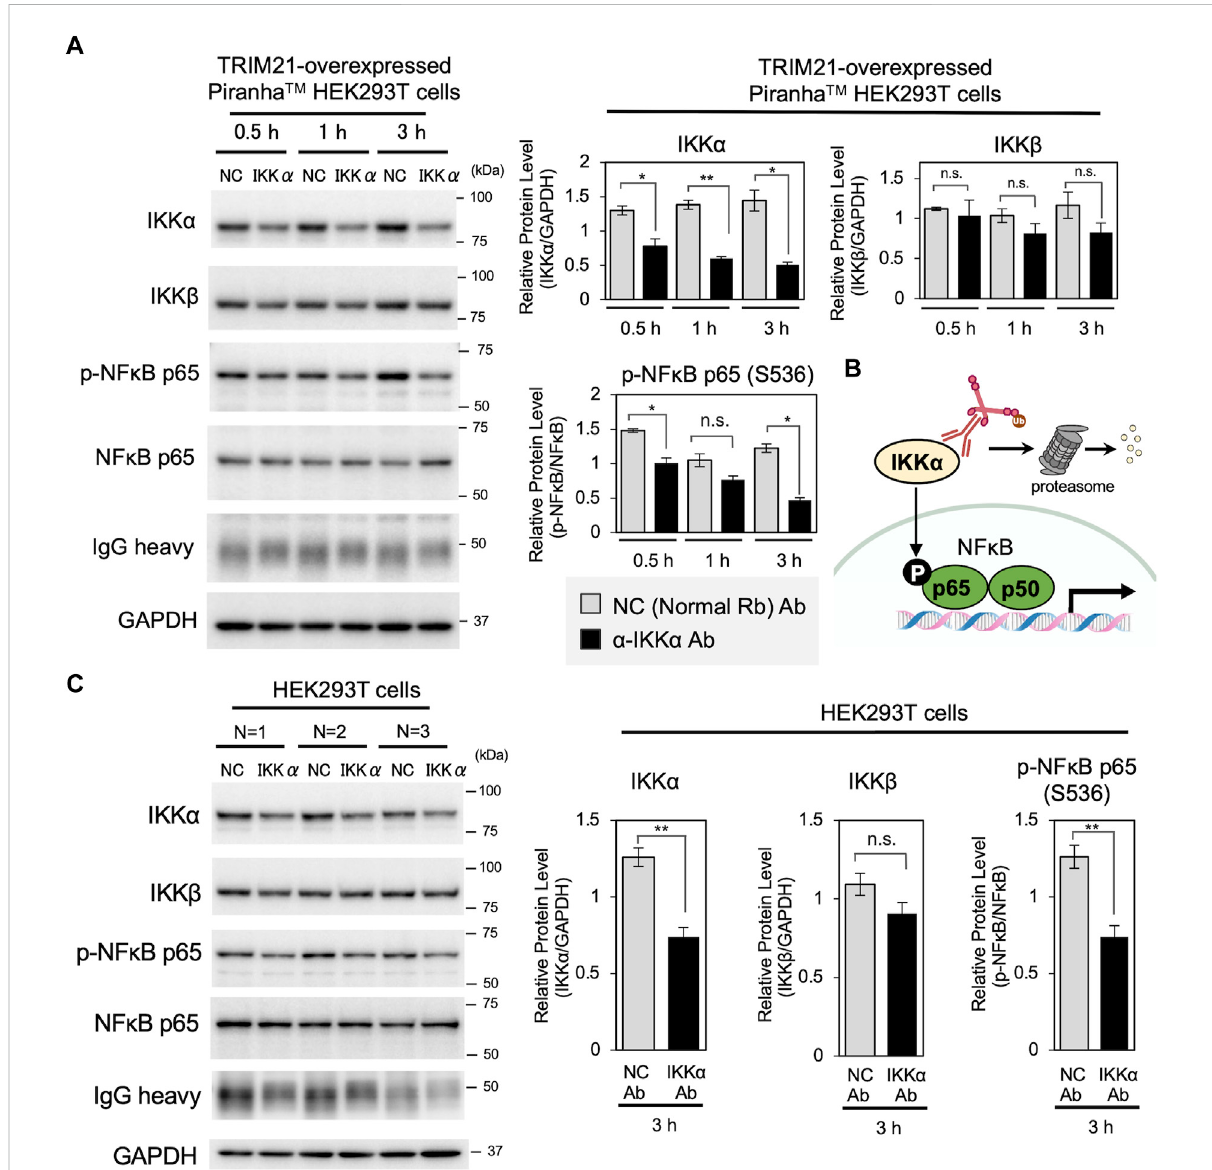
FIGURE 2 Acute degradation of IKK α by cell resealing technique-mediated Trim-Away. (A) Western blotting showing acute degradation of IKK α by cell resealing technique-mediated Trim-Away. TRIM21-overexpressed Piranha TM HEK293T cells were incubated for 0.5, 1.0, and 3.0 h after resealing with 0.25 mg/ml of anti-IKK α antibody (clone Y463, Abcam, Cat# ab169743) or the same amount of normal rabbit antibody as a non-targeting negativecontrol(NC).Resealingofanti-IKK α antibodyledtoa40%reductioninIKK α proteinlevelswithin30 min,whichwasfurtherreducedby 65% in 3 h. Only a slight decrease in IKK β was observed. Phosphorylation of NF- ĸ B p65, downstream of IKK α , was also decreased under anti-IKK α - resealedconditions.Dataexpressedasmean±SEM( n =3).* p < 0.05,** p < 0.01,ns:notsigni fi cant.Rb:rabbit,Ab:antibody. (B) SchematicoftheIKK α Trim-Away experiment. (C) Western blotting results of HEK293T cells that underwent the same resealing procedure described in A were incubated for 3 h and were collected for analysis. Approximately 41% of the IKK α was degraded, which was limited compared with that in TRIM21- overexpressed Piranha TM HEK293T cells. Data are expressed as mean ± SEM ( n = 3). **P < 0.01, ns: not signi fi